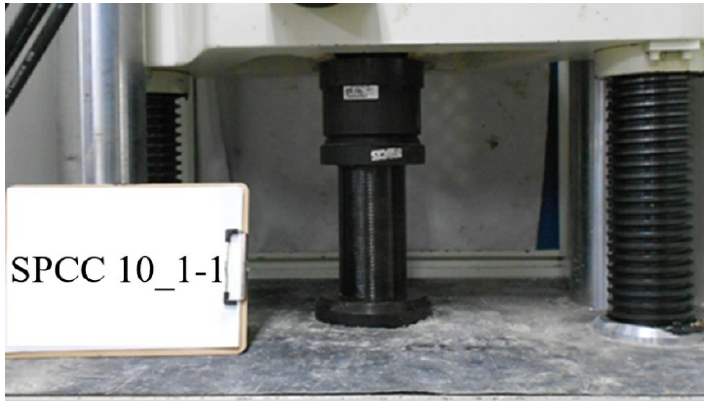
Figure 3. Compressive strength test for the cylindrical CFRP-confined specimen.